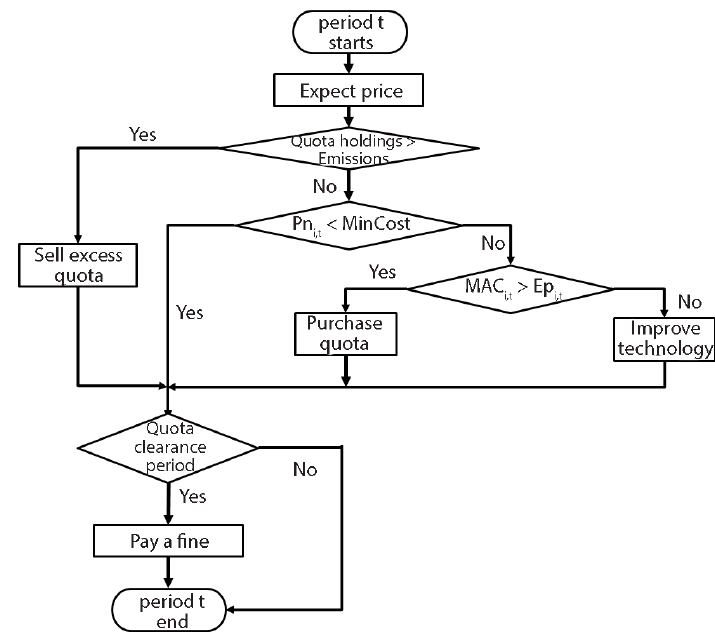
Figure 3. Decision flow